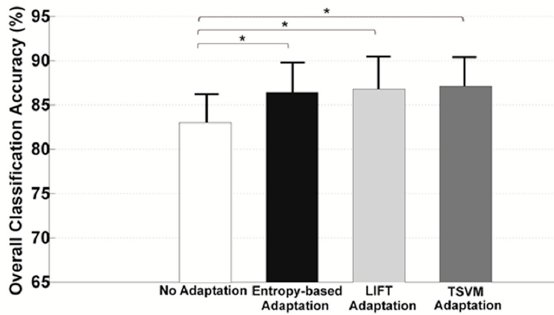
Figure 7. Classification accuracy averaged across the last five testing trials and across all the tested subjects. * indicated a statistically significant difference (one-way ANOVA, p < 0.05).